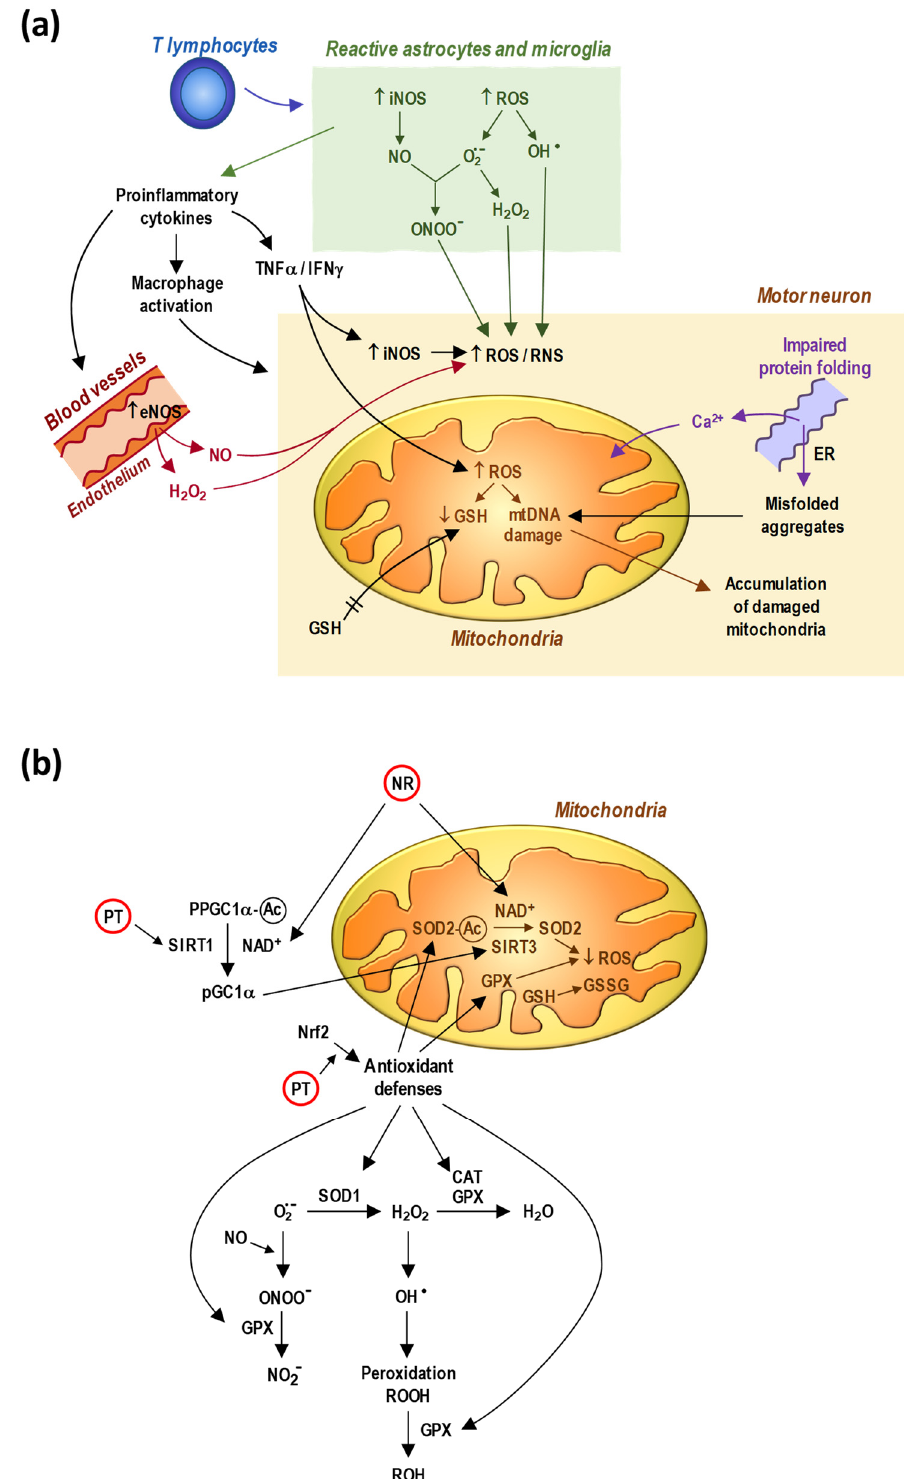
Figure 1. The association of NAD + boosters and antioxidants may interfere in the pathophysiology of ALS and be beneficial for the protection of motor neurons. Reactive oxygen and nitrogen species (ROS and RNS) can be generated by reactive glial cells, endothelial capillary cells, and the motor neurons. Recurring stress could generate a vicious cycle of accumulated damages until reaching a limit of no return that leads to the inevitable death of MNs: ( a ) cellular interactions that condition mitochondrial damage associated with the activation of cell death; ( b ) in the molecular